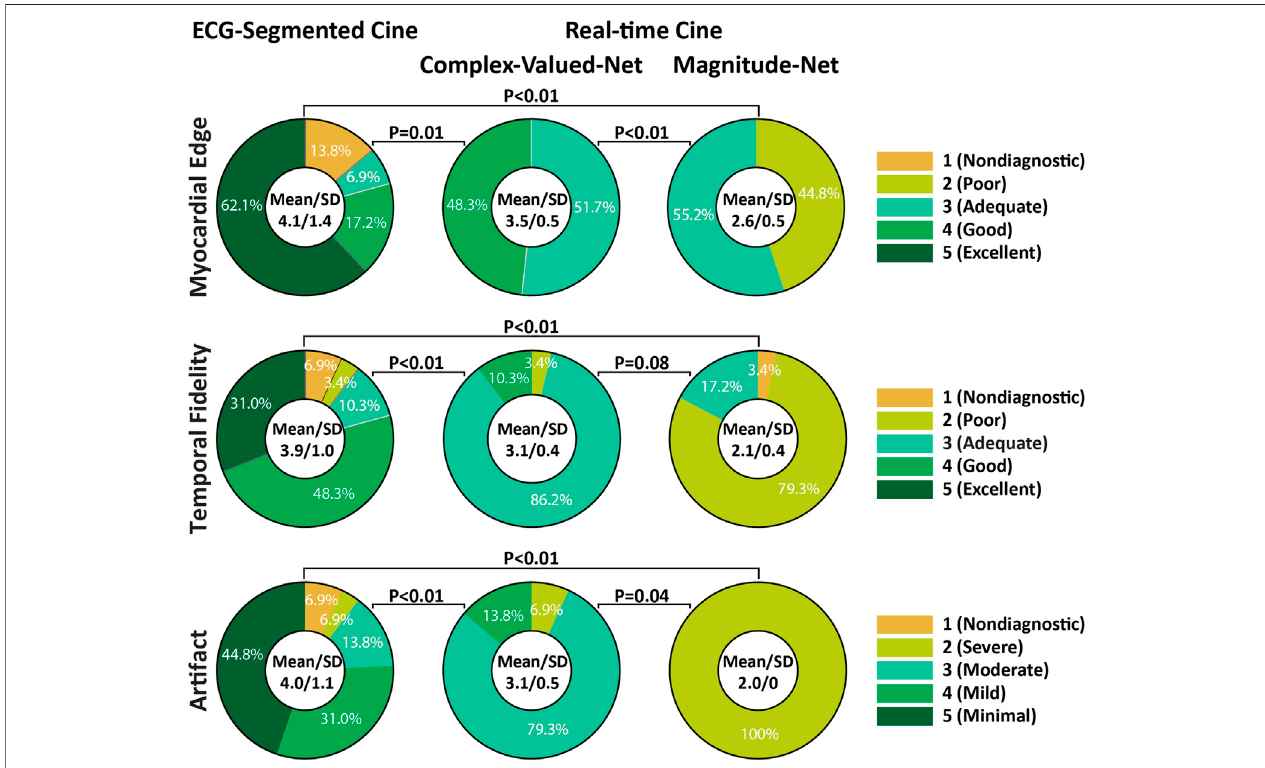
FIGURE4| Distributionandaverageimagequalityscoresacrossallcineimagesof29patientsbythreemethods:ECG-segmentedcine,Complex-Valued-Netreal- time cine, and Magnitude-Net real-time cine. The P-values of z-tests between every two methods regarding each criterion are labeled. Real-time cine by Complex- Valued-Net reconstruction yielded superior subjective scores for all three criteria compared to those by Magnitude-Net. ECG-segmented breath-hold cine had the highest score across all three criteria.